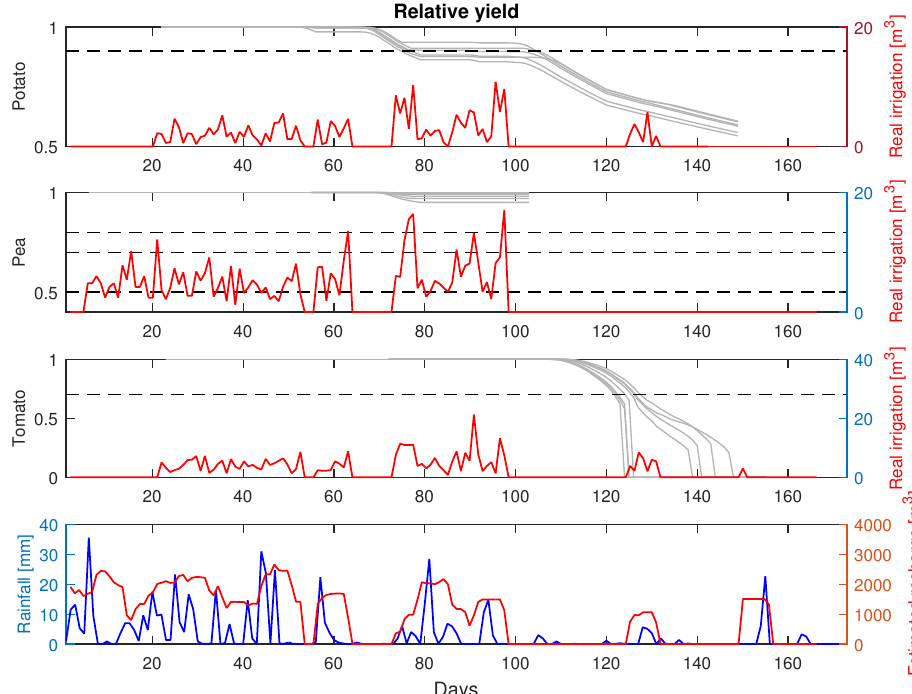
Figure 8. EWMS for crop yields, irrigation, rainfall, and estimated recharge for scenario 1 ( S 1 ). The left y-axis in the potato, pea, and tomato plots indicates the relative yield of the different crops (gray) and their expected relative yields (dashed line), and the right y-axis indicates the irrigation (red). The fourth plot shows the measured rainfall (blue) and the estimated recharge (red).